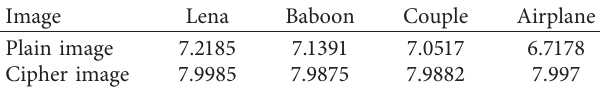
Table 6: Quality evaluation metrics of decrypted images. Image PSNR NCC